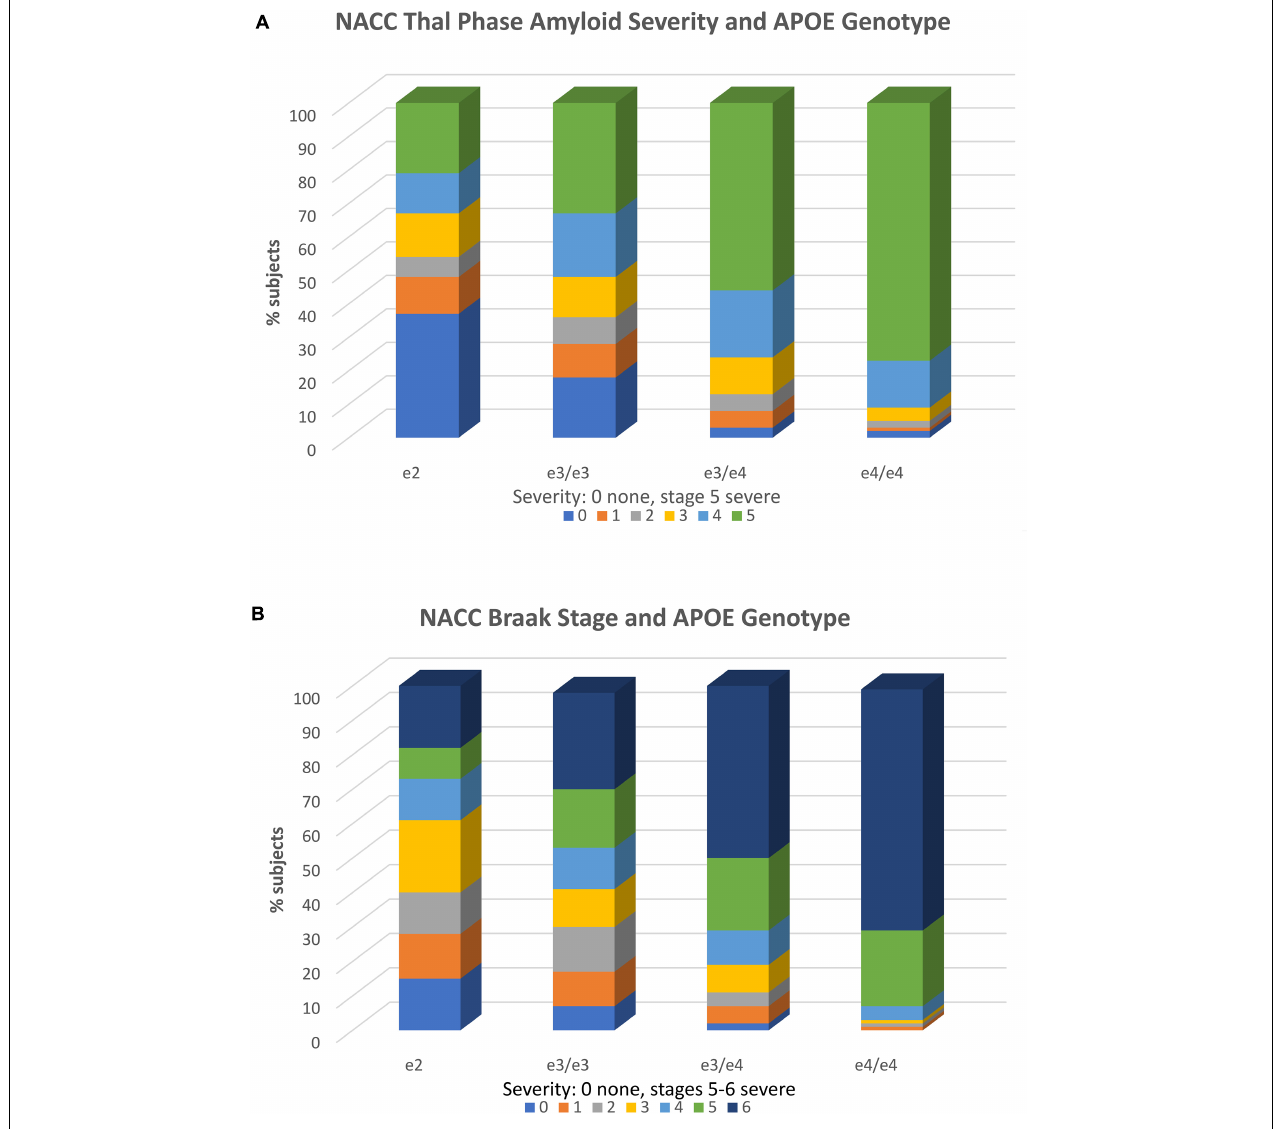
FIGURE 2 | APOE genotype and neuropathology. (A) Association of APOE genotype and diffuse amyloid plaque extent (Thal phase). Within each APOE genotype column, colored rows represent the relative proportion of cases in each severity stage. These proportions are expressed as percentages and add to 100. There are increasing proportions of the most severe pathology (plaque stage 5) from the e2 to e4/e4 genotype groups in stepwise fashion. Stage 1 includes one or more neocortical regions with Ab immunopositivity, stage 2 includes hippocampal positivity, and stages 3–5 include other limbic and subcortical structures. Amyloid stage 0 = no pathology; stage 5 = widespread cortical, limbic, and subcortical pathology. Stages 1 and above are consistent with AD. The total N = 1,557. Reproduced with permission Goldberg et al. (2020a). (B) Association of APOE genotype and Braak stage. Within each APOE genotype column, colored rows represent the relative proportion of cases in each severity stage. These proportions are expressed as percentages and add to 100. There are increasing proportions of the most severe pathology (Braak stages 5 and 6 from the e2 to e4/e4 genotype groups in stepwise fashion. Braak stage characterizes the spread of neurofibrillary tangle pathology from entorhinal cortex (stages 1 and 2), to increasing involvement of the hippocampus (stages 3 and 4), to neocortical involvement (stages 5 and 6) (Braak stage 0 = no pathology; stage 6 = severe neocortical pathology. Stages 3 and above are consistent with AD. The total N = 1,557. Reproduced with permission Goldberg et al.